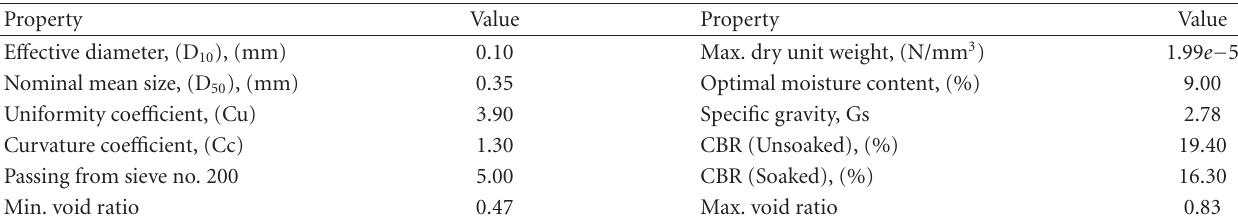
Table 1: Physical and mechanical properties of fine grained